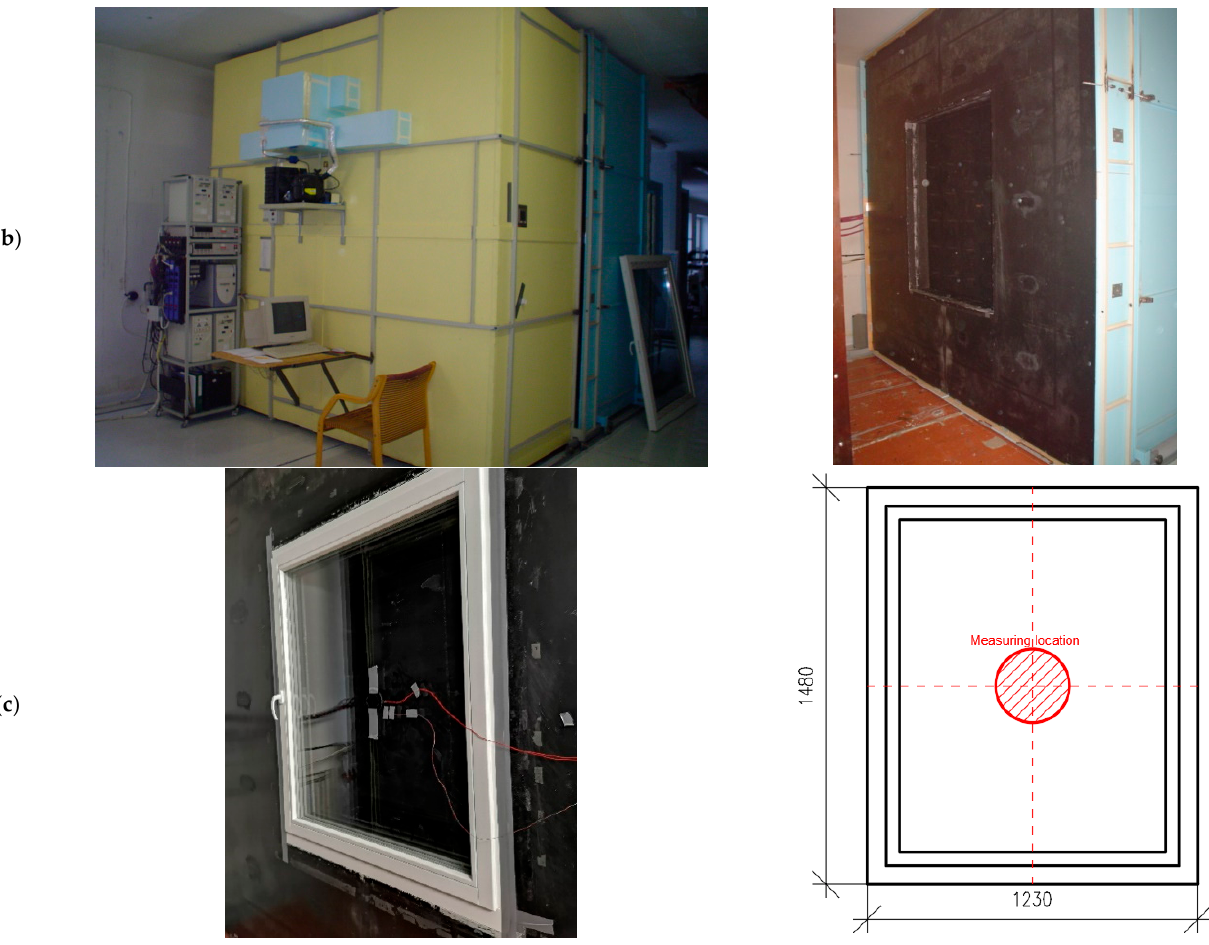
Figure 1. ( a ) Scheme of climate chamber “hot box”; 1. Warm side guard box: internal dimensions 2800 × 2800 × 1100 mm; wall thickness 130 mm, total thermal resistance approximately 3 m 2 · K/W; 2. Guard box’s air flow deflecting screen; 3. Electrical heater, power 660 W, controlled according to a set point temperature in the metering box (6); 4. Electrical heater of the metering box, power control from 13 W to 660 W; 5. Warm side baffler (of the metering box) with surface and air temperature sensors; 6. Metering box: Internal dimensions 2400 mm × 2400 mm × 360 mm; 7. Surround panel: 200 mm thick, core material EPS polystyrene (faced with 3 mm thick cellular PVC plastic sheet on either side); thermal resistance approximately 6 m 2 · K/W; 1484 mm (h) × 1234 mm aperture for window specimen mounting, 2055 mm (h) × 1234 mm aperture for door specimen mounting; 8. Cold side box: Internal dimensions 2800 mm × 2800 mm × 1100 mm; wall thickness 130 mm, total thermal resistance about 3 m 2 · K/W; 9. Cold side baffler with surface and air temperature sensors; 10. Cold side controlled cooling air unit, maximum cooling power up to 3 kW; 11. Cold side air cooling box with five speed motor fan; 12. The tested window. ( b ) Photos of closed and opened GHB. ( c ) Measurement location of the heat flow meter and differential thermocouple on the insulating glass unit (IGU) of